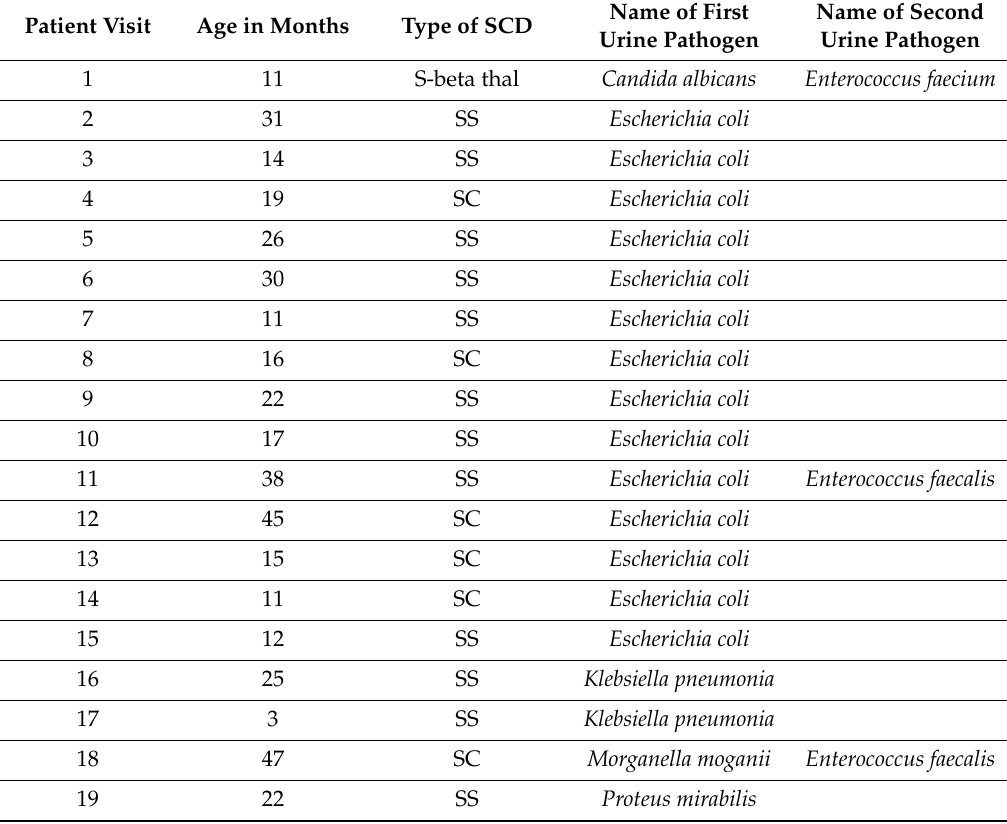
Table 3. Urine culture results ( n = 19 patient visits).